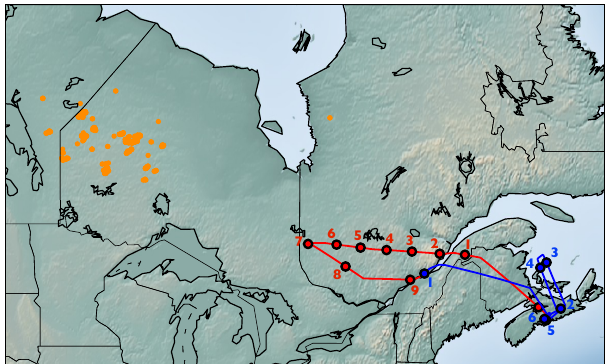
Figure 1. BORTAS-B ARA research Flight b622 (red) from Nova Scotia to Quebec and the return Flight b623 (blue), both on 20– 21 July 2011. Circles represent midpoints of ascent/descent tran- sects along the flight paths. The ARA flew through biomass-burning emissions originating from fires in northwestern Ontario. The 17– 20 July 2011 MODIS hotspot fires (fire radiative power>100MW) are plotted in